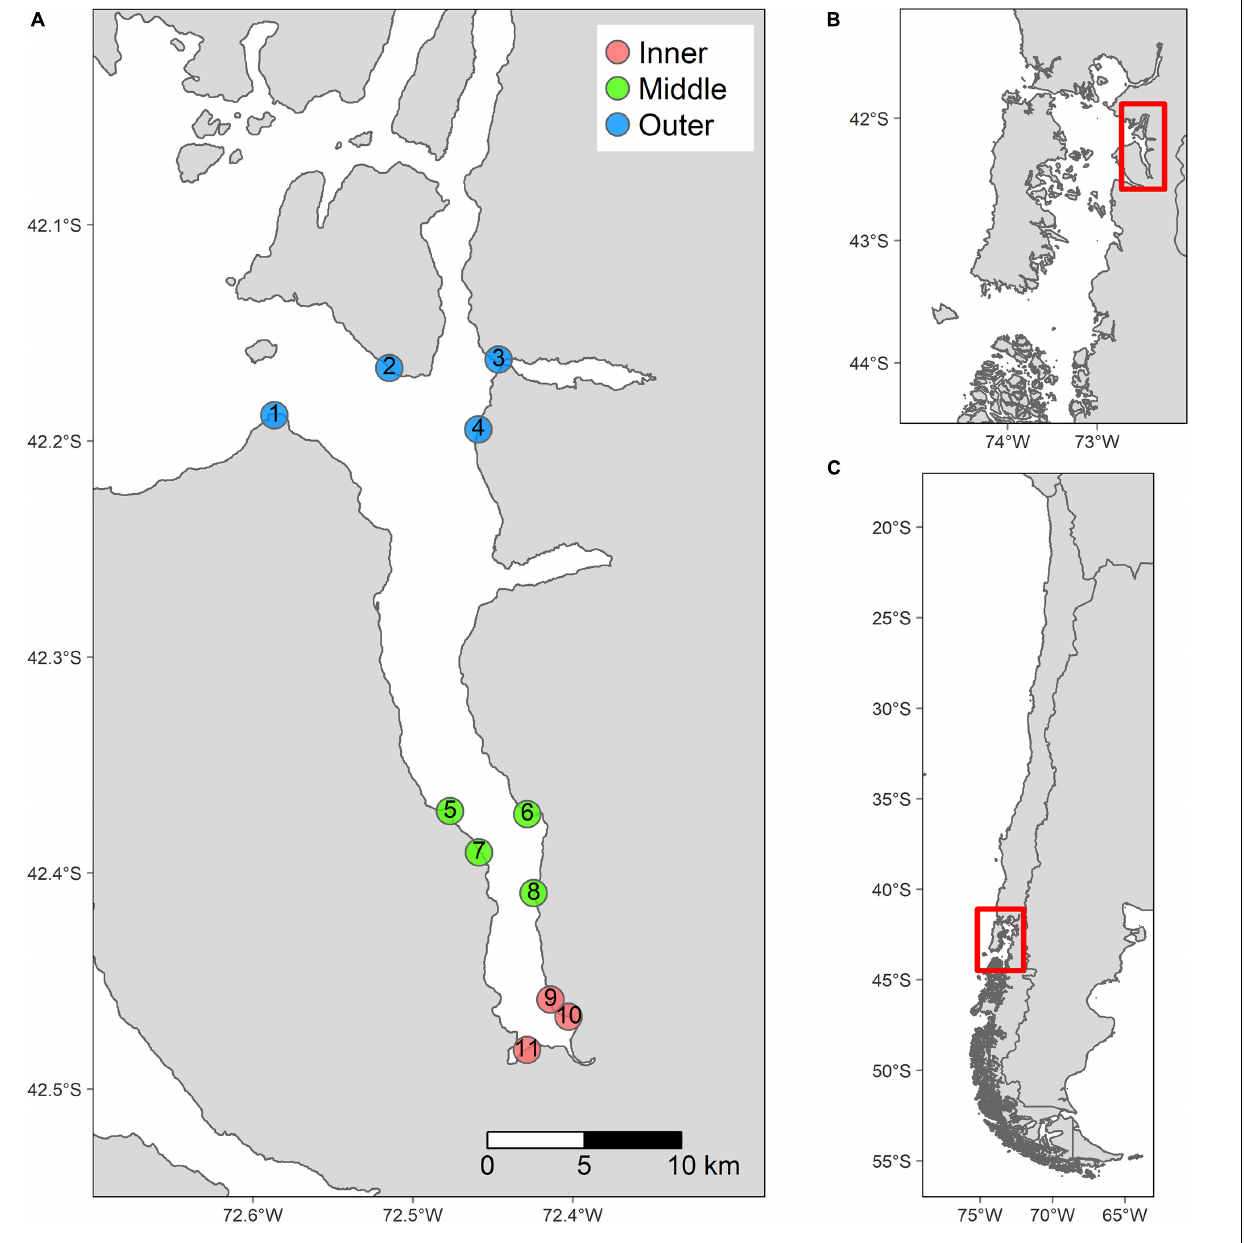
FIGURE 1 | Study site and experimental design. (A) Map of the Comau Fjord with the sampling sites (circles) nested within the head, middle and mouth sections of the fjord (colors). (B) Northern Patagonia with Comau fjord highlighted by a red square. (C) Section of the Southern Cone of South America with the Northern Patagonia highlighted by a red